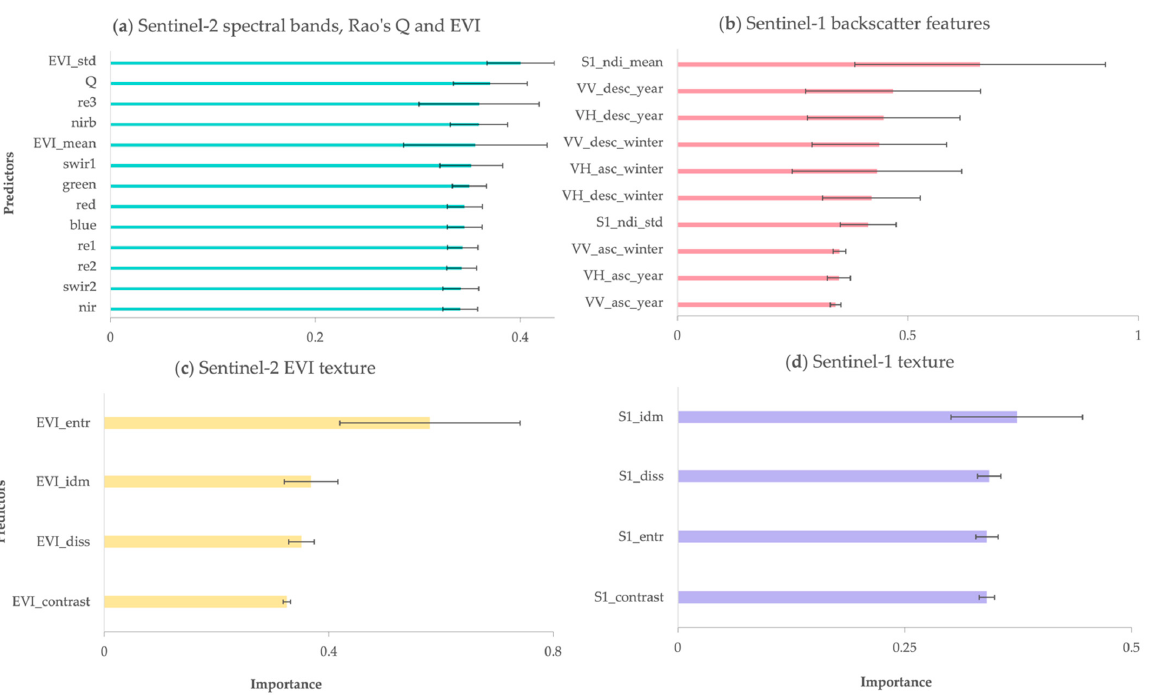
Figure 6. Predictor importance for tree species diversity models for the four different feature groups ( a – d ). The error bars indicate the variation in importance across the ten folds where training and validation data have been randomized.